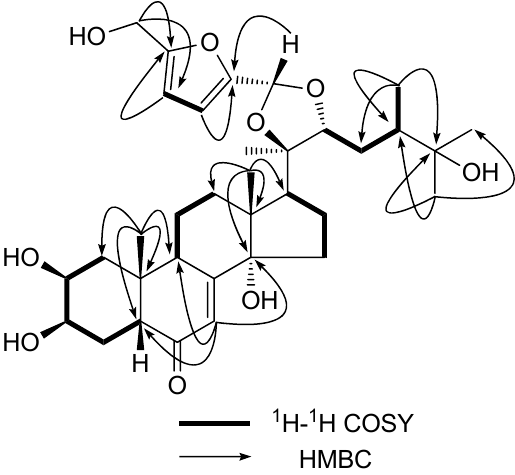
Figure 2. Selected 2D NMR correlations of Niuxixinsterone A ( 1 ).